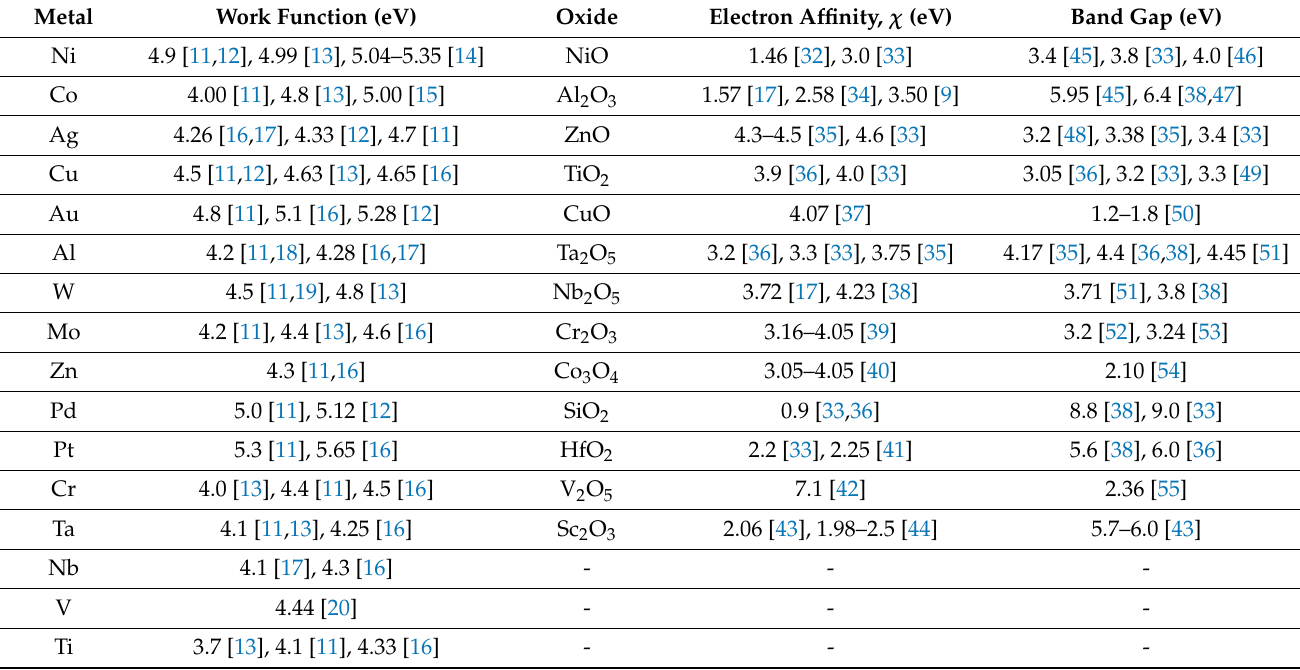
Figure 3a,b present electron affinities [9,17,32–44] and band gap